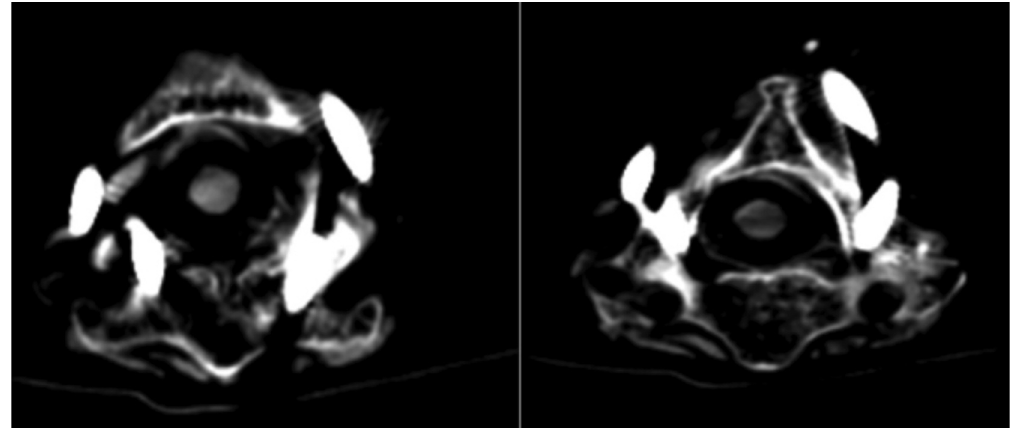
Post-operative CT scan for checking the screws’ Fig. 8: